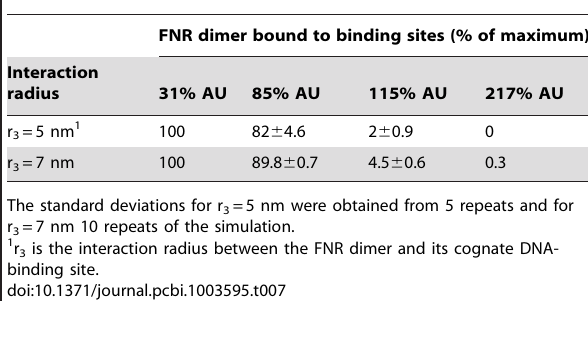
Table 7. The effect of interaction distance (r 3 ) for binding of FNR dimers to target DNA on wild-type FNR